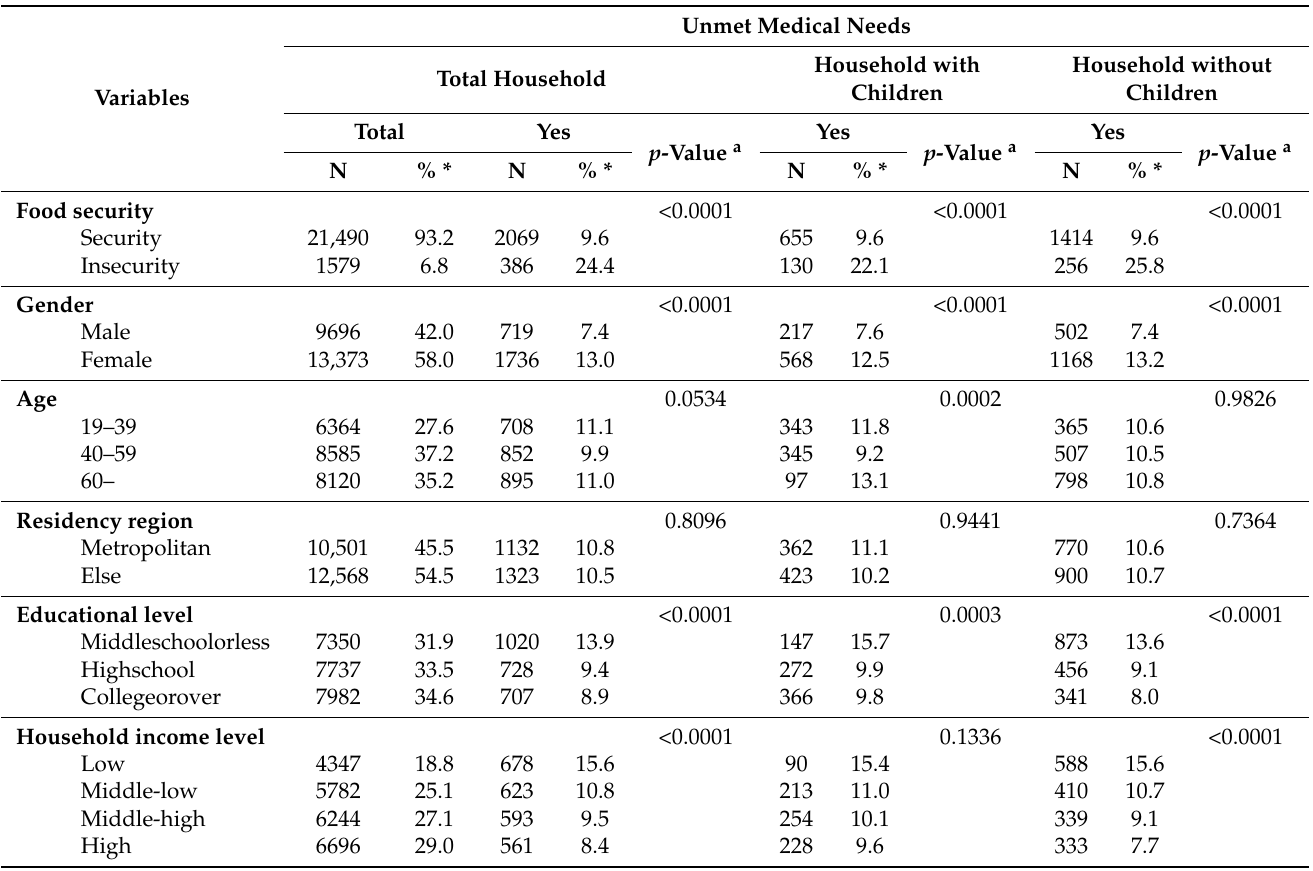
Table 1. General characteristics of participants at